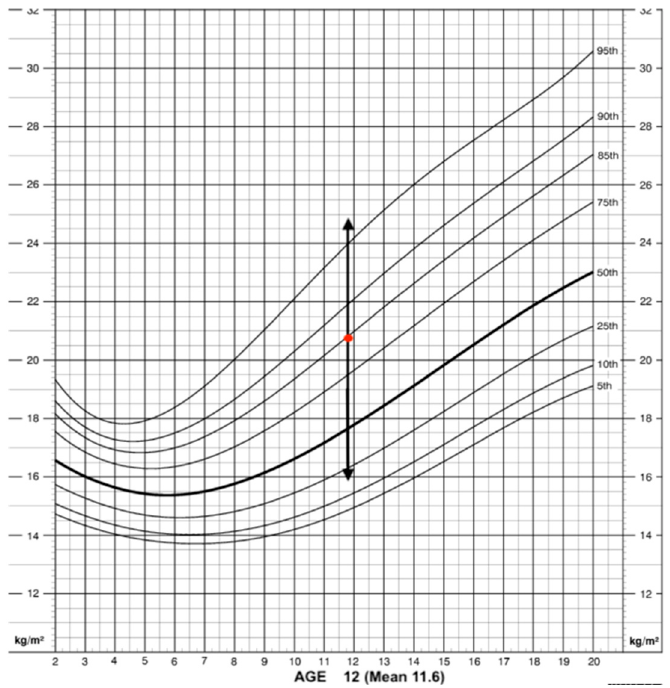
Figure 2. BMI according to percentiles: boys.